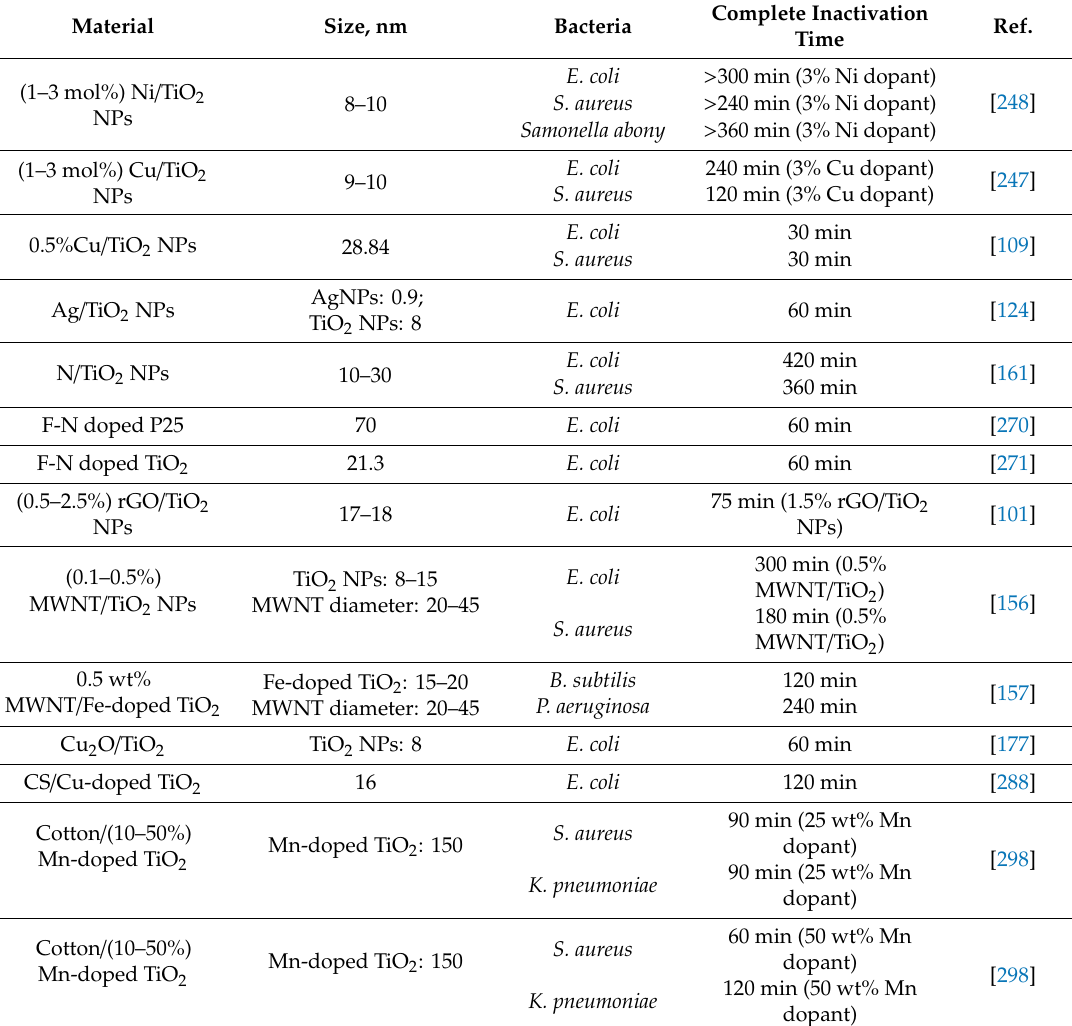
Table 2. Bactericidal performance of modified titania nanoparticles under visible